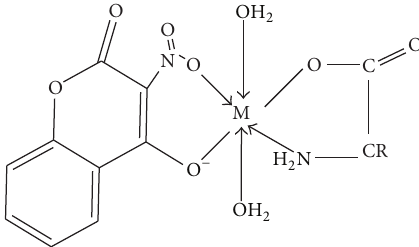
Figure 4: Proposed structure for compounds 4 and 6 . R=– H, compound 4, and –C 4 H 8 , compound 6